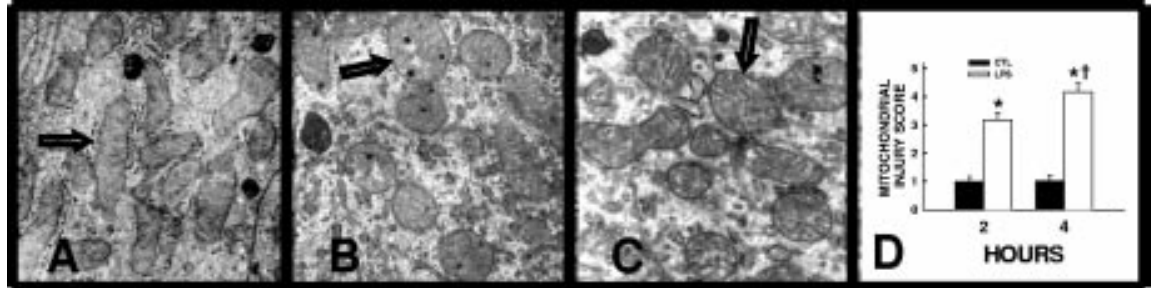
Fig. 1. Representative electron photomicrographs of ileal mucosal mitochondria. (A) Control animal 4 hours post-treatment; (B) LPS-treated animal 2 hours post-treatment; (C) LPS-treated animal 4 hours post-treatment; (D) Injury scores as determined using qualitative criteria defined in Table 1 (mean (cid:6) SEM). In comparison to the normal mitochondrial ultrastructure in control, LPS treatment caused significant ultrastruc- tural injury (see arrows in (B), (C)). Mild to moderate mitochondrial swelling was typical of most of the LPS-treated animals by 2 hours (B), while high amplitude swelling with concomitant loss of membrane integrity was often observed by 4 hours post-treatment (C). (Magnification: 55,000 (cid:2) ; Staining: 2% uranyl acetate and Reynolds lead citrate). Significant mitochondrial ultrastructural injury was apparent within 2 hours and worsened by 4 hours following LPS treatment ( (cid:3) p < 0 : 001, compared to time-matched Controls; y p < 0 : 01, compared to corresponding 2-hour